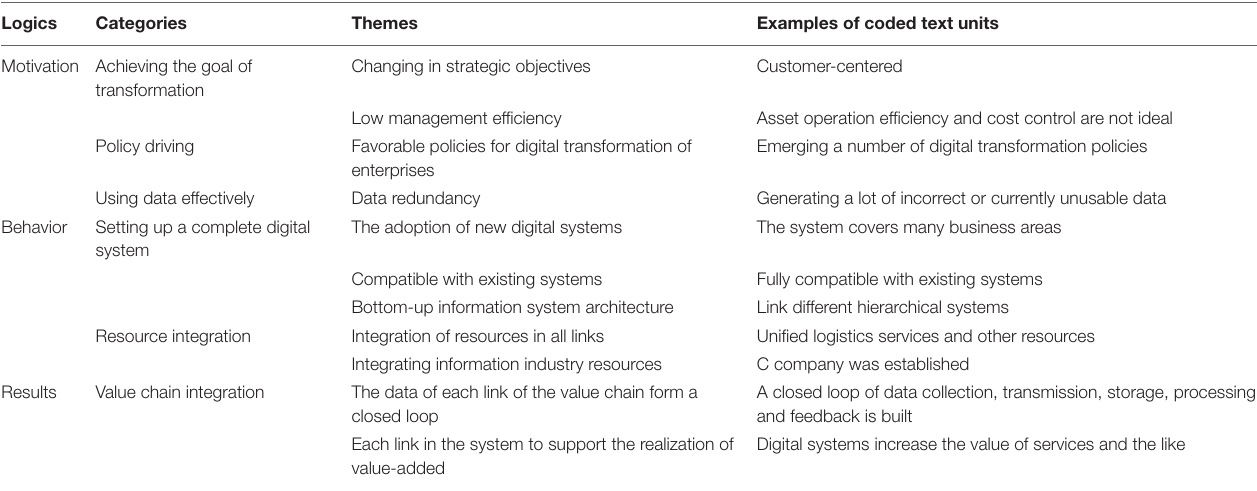
TABLE 3 | Phase 2 value chain